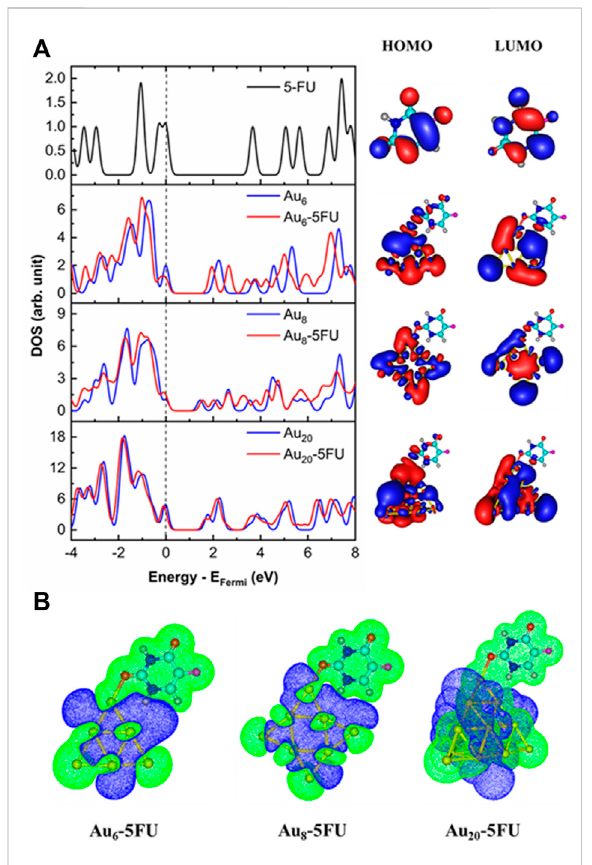
FIGURE 7 Density of states, HOMO and LUMO (A) and charge density difference maps (B) for the most stable complexes, Au N -5FU_1. The Fermi energy (E Fermi ) level is corrected to the zero reference.